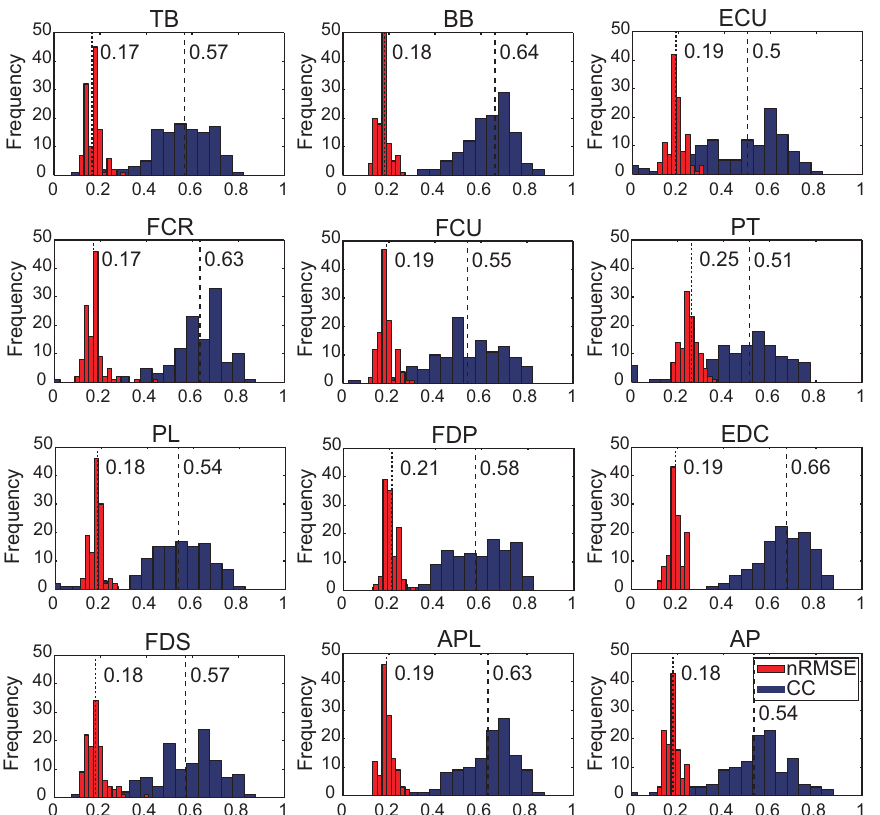
Figure 4. CC and nRMSE distributions for each muscle of monkey A. The height of each blue bar is equal to the CC density of the interval (0.05). The height of each red bar is equal to the nRMSE density of the interval (0.02). The total area of the histogram is equal to the number of trials used as validation data. Each dotted line with a number shows the median of nRMSE or CC for each muscle. For visualization, we substituted zeros for all negative CC values in validation.